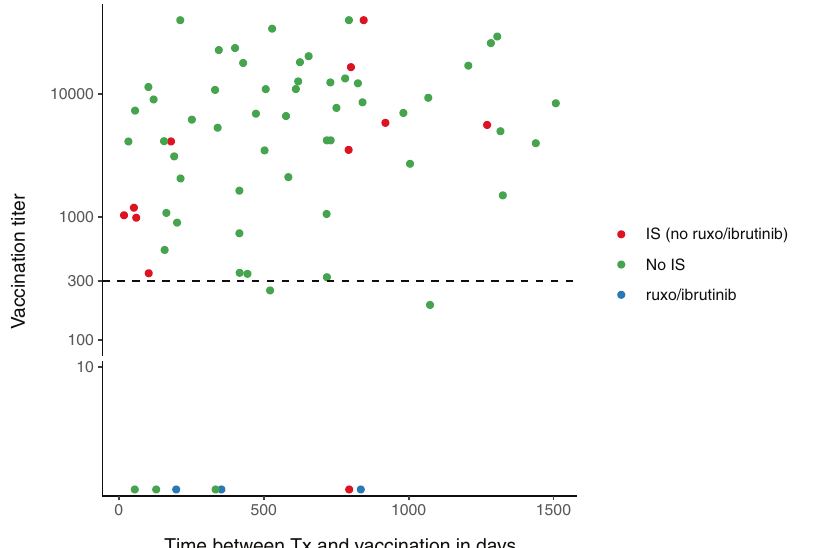
Fig. 1 Relationship between antibody titer after COVID vaccination and time after allogeneic stem cell transplantation with post transplantation cyclophosphamide containing conditioning. Vaccination titer in